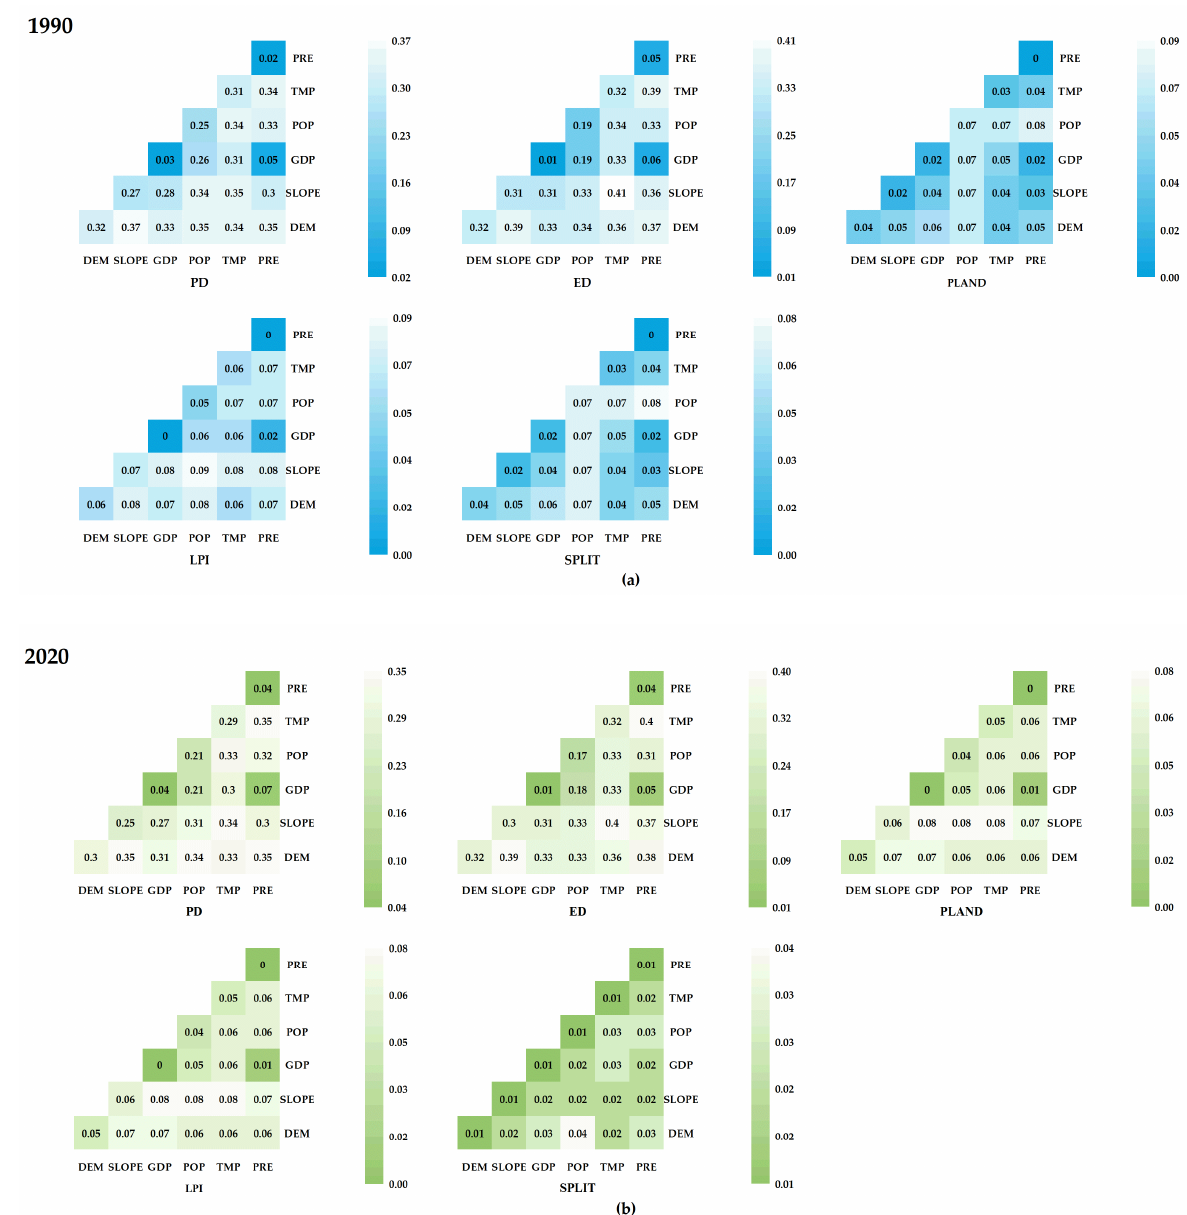
Figure 11. The force (q-value) among any two influencing factors on each landscape pattern metric interactively in ( a ) 2000 and ( b )